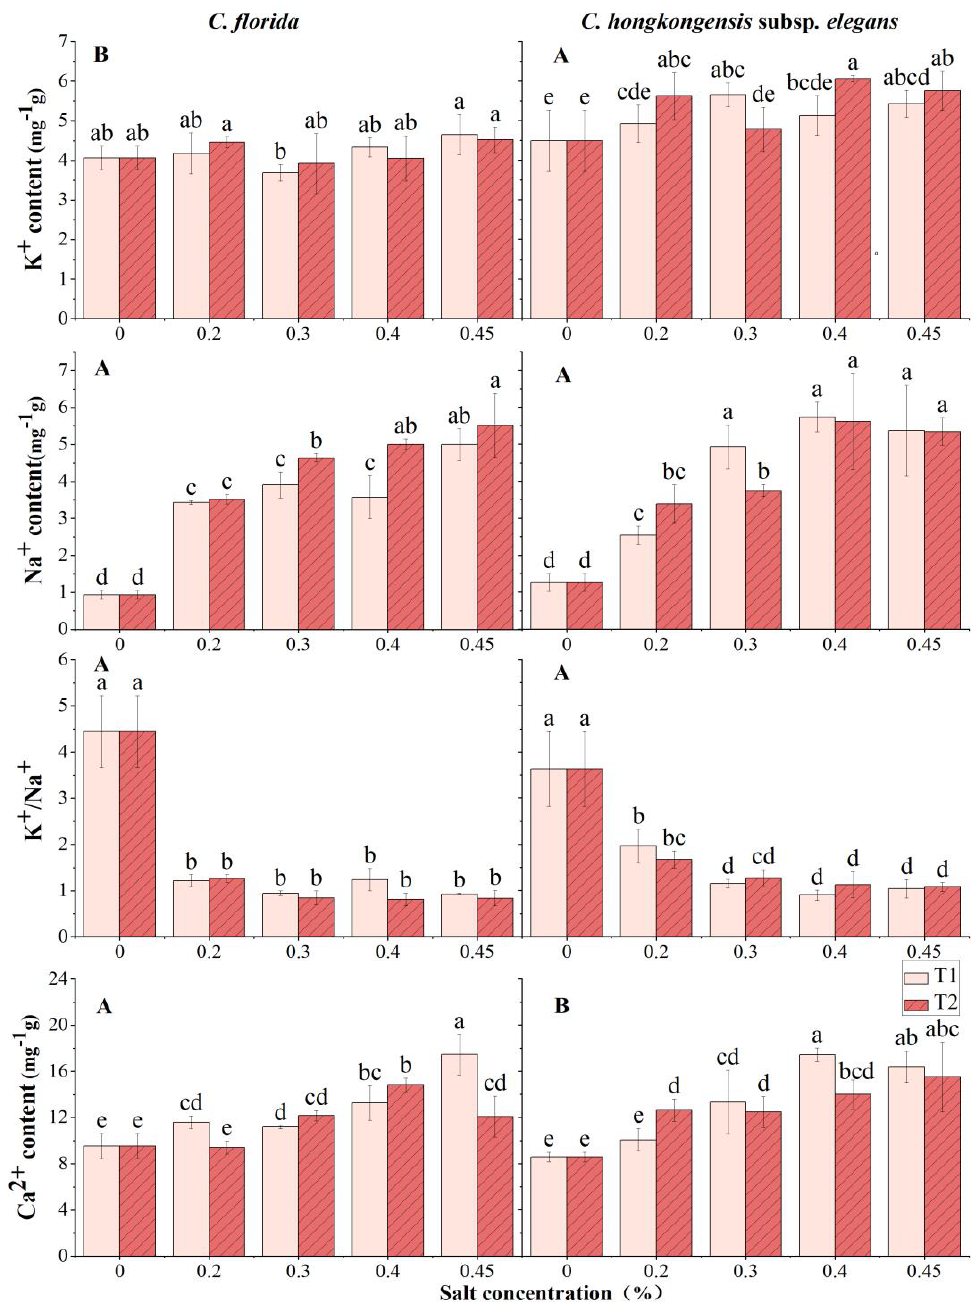
Figure 3. The changing patterns of K + , Na + , and Ca 2+ contents and K + /Na + ratios in the shoots of C. florida and C. hongkongensis subsp. elegans seedlings that were subjected to salt stress.